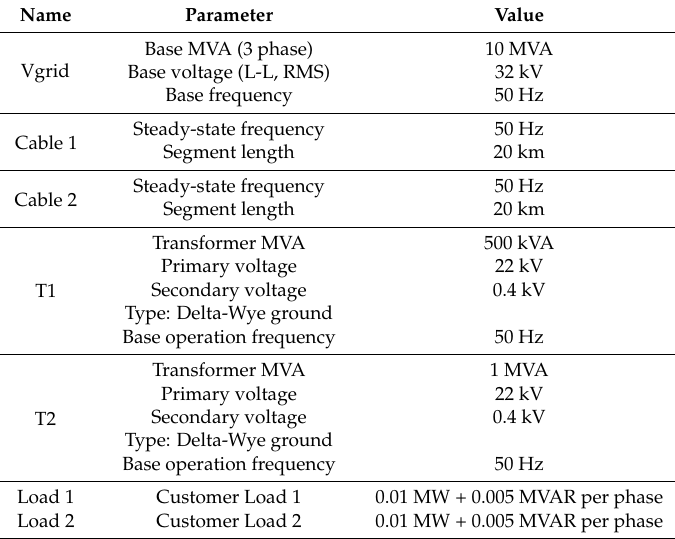
Table 1. The parameters for simulation Case I.